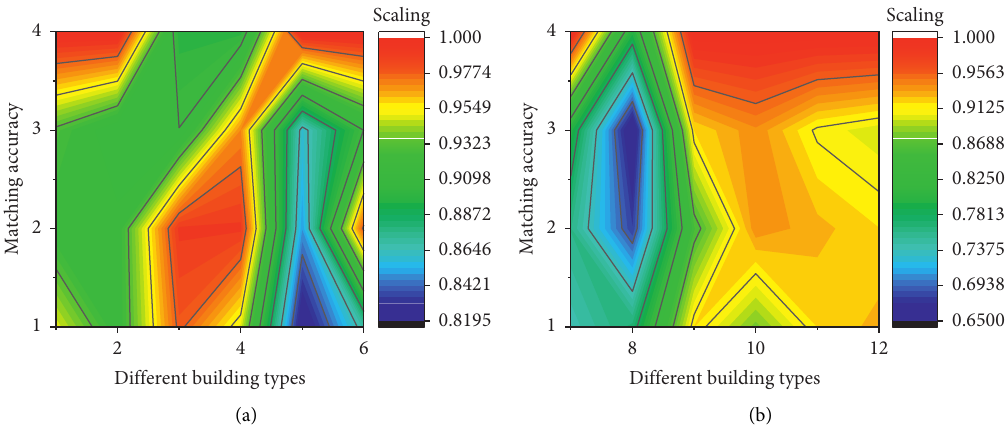
Figure 14: Statistical results of detection and matching accuracy of some